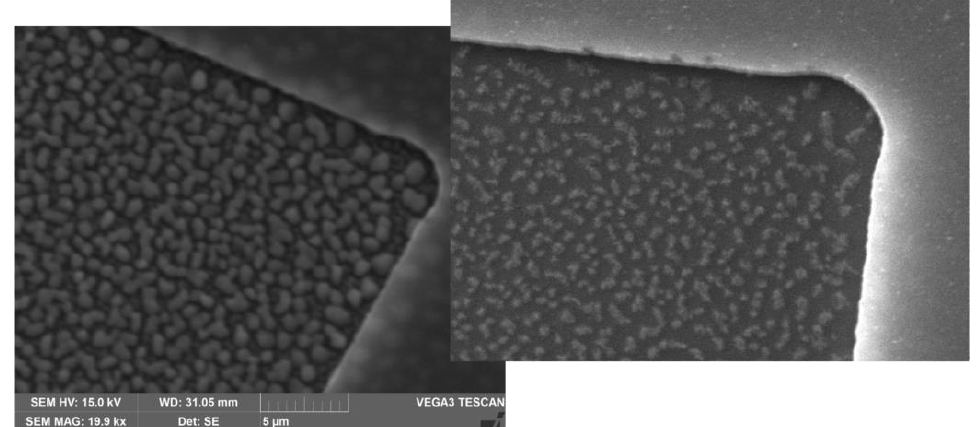
Figure 3. Residuals after HF vapor etching ( left ) and the effect of baking at 150 °C on the HF vapor residuals ( right ).